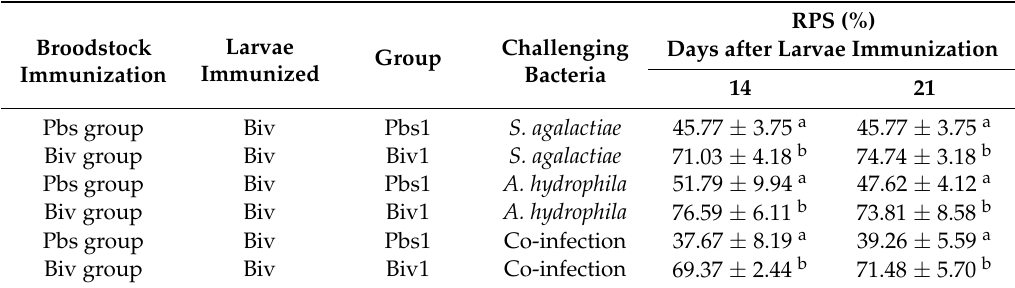
Table 2. Relative percent survival of tilapia larvae Biv1 and Pbs1 were challenged with S. agalactiae , A. hydrophila , and coinfection at 14 and 21 days after larval immunization.